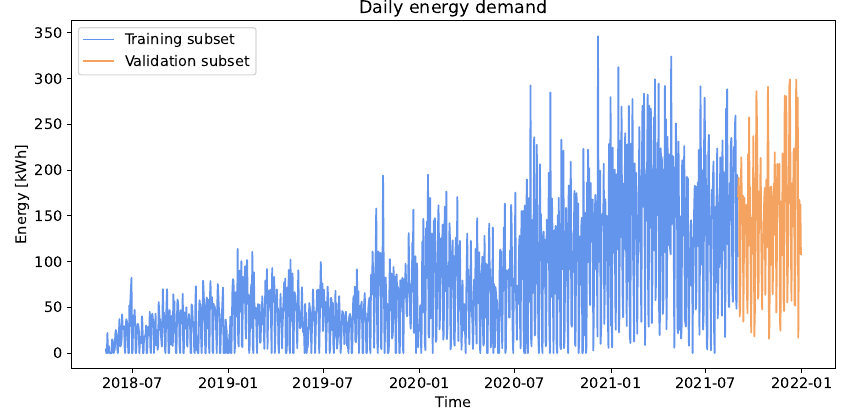
Figure 5. Daily charging energy demand